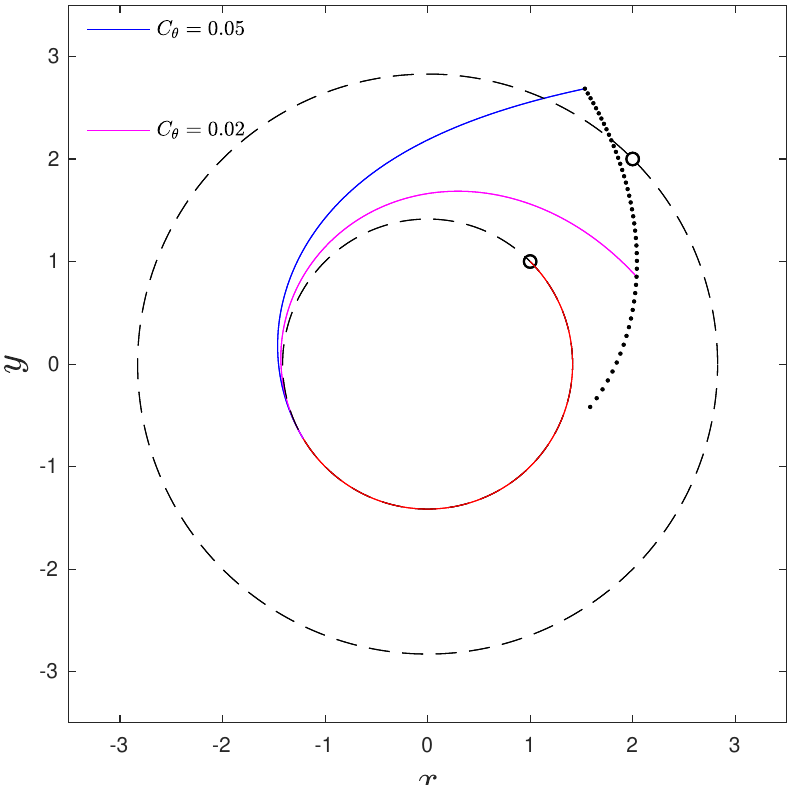
Figure 1. We want to move the particle from ( 2,2 ) to ( 1,1 ) . The red line represents the motion of the particle during the second regime, while the blue and pink lines represent two possible trajectories on the first regime for different C θ . The black dots represent possible initial positions for the particle for different values of C θ . We see that even if we change C θ , we cannot reach the desired initial position (represented by the open circle), so we have to change ˜ t